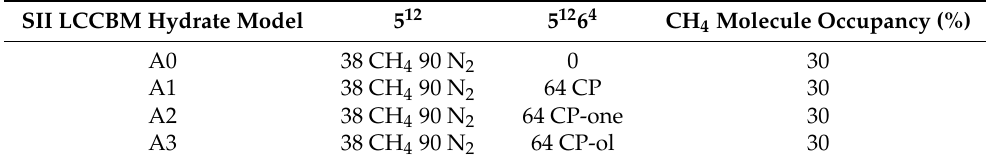
Table 1. The LCCBM hydrate